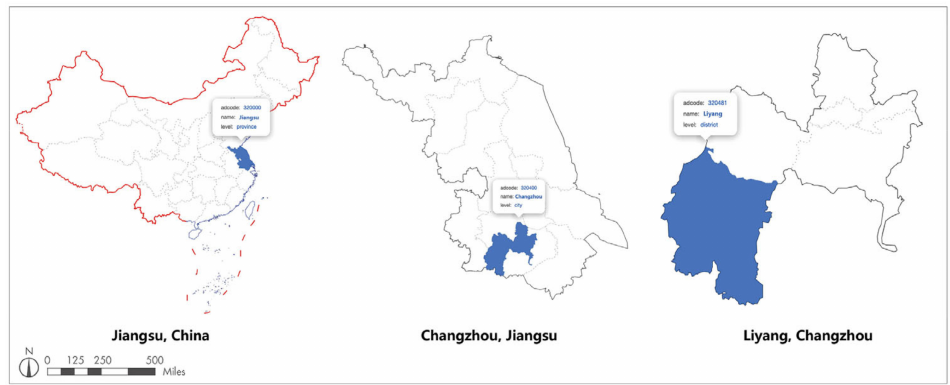
Figure 2. Location map of